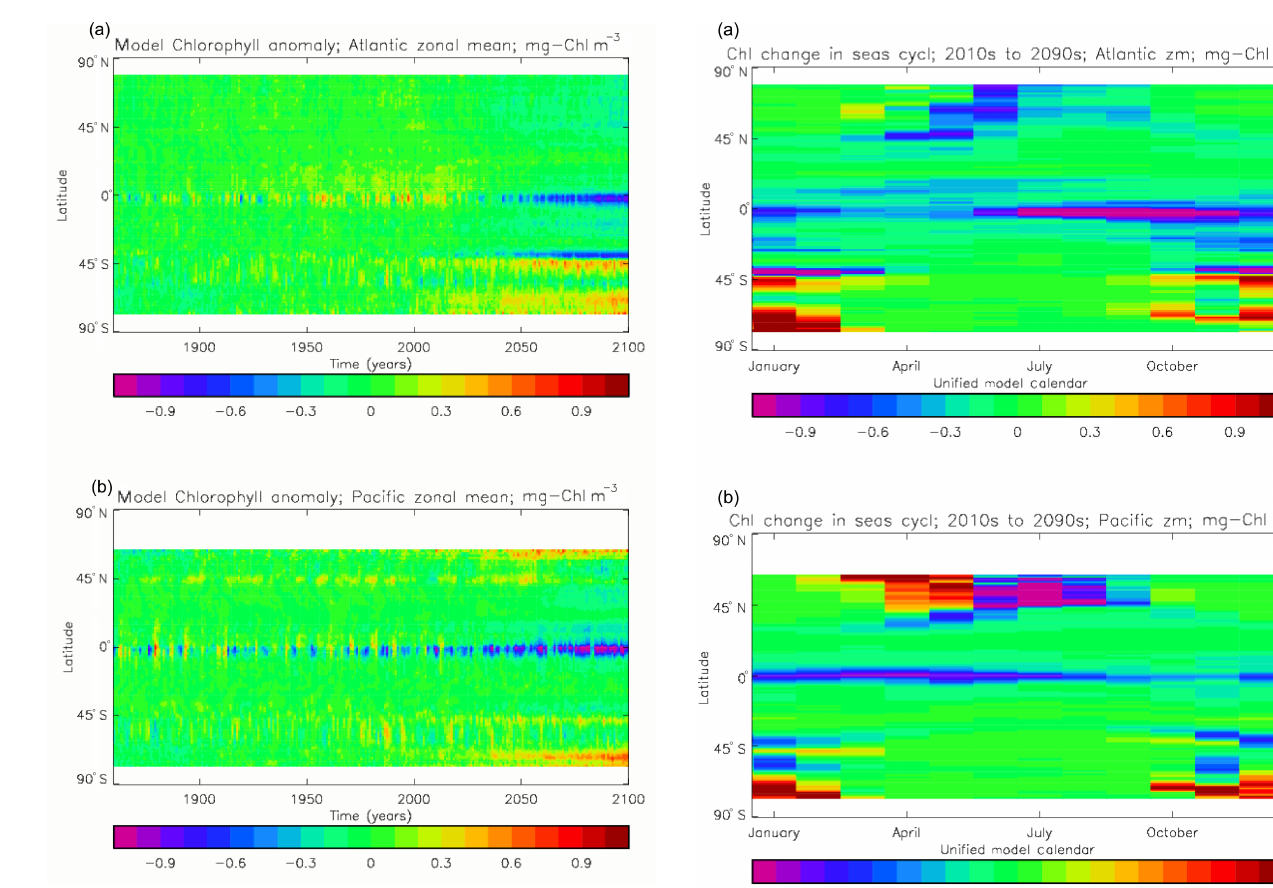
Figure 35. Surface total chlorophyll concentration anomaly (mgChlm − 3 ), zonal and annual means for model years 1860 to 2099 from the CMIP5 historical and RCP8.5 simulations: (a) zonal mean of the Atlantic Ocean basin; (b) zonal mean of the Pacific Ocean basin. The anomaly has been calculated by subtracting the surface chlorophyll concentration field, meaned over the years 1860 to 2099, as produced by the piControl simulation from the annual means of the historical and RCP8.5 simulations.